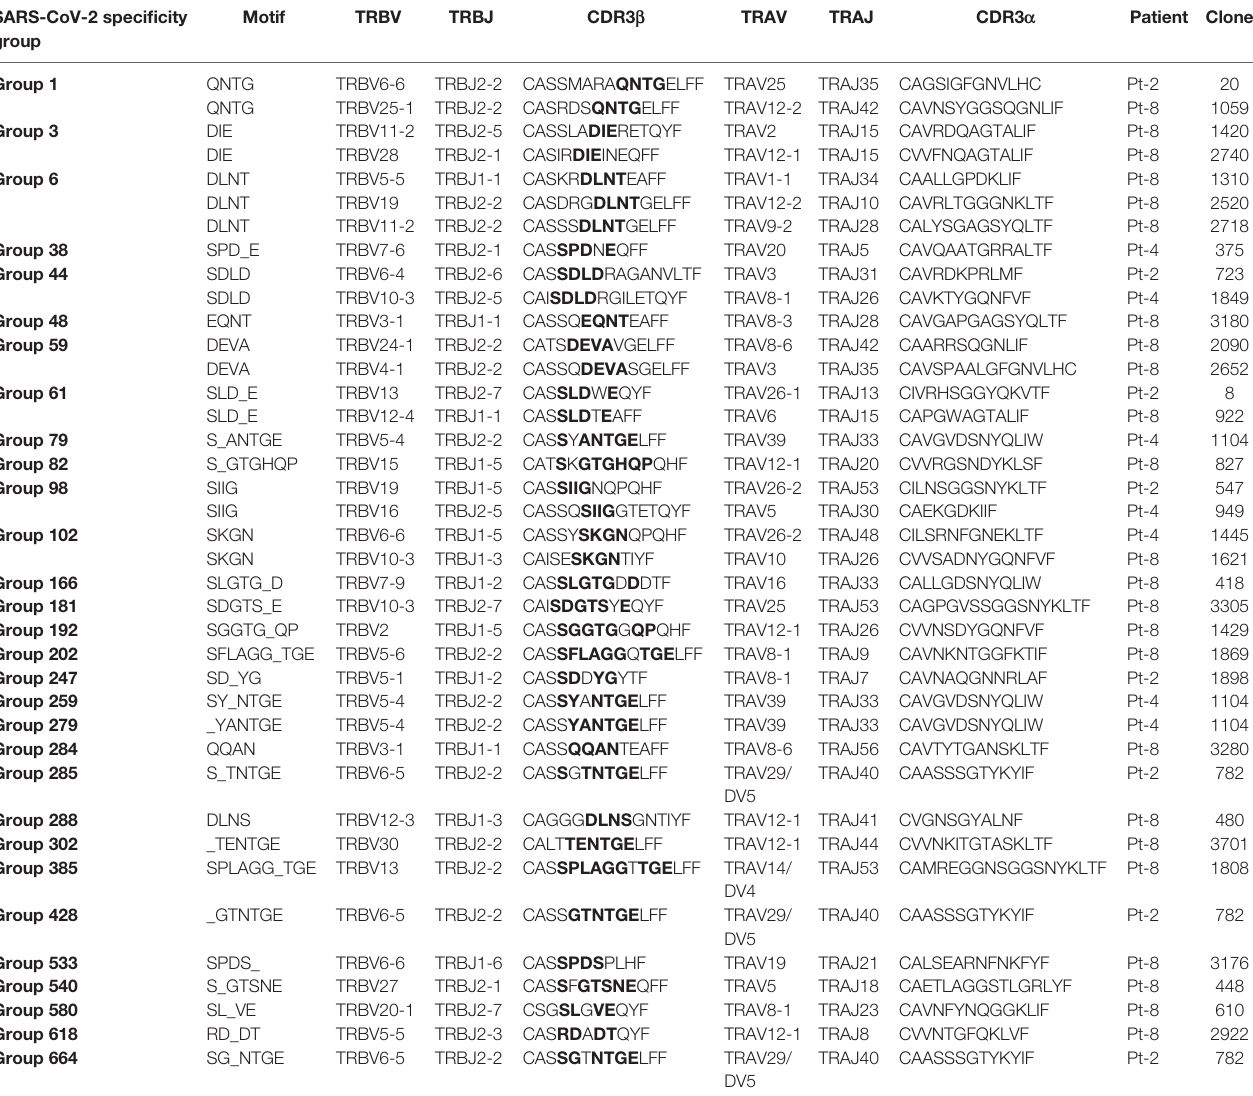
TABLE 1 | Patient TCRs with predicted SARS-CoV-2-speci fi city, as determined by GLIPH2 clustering with known HLA-A*02:01-restricted SARS-CoV-2-speci fi c TCRs. SARS-CoV-2 speci fi city